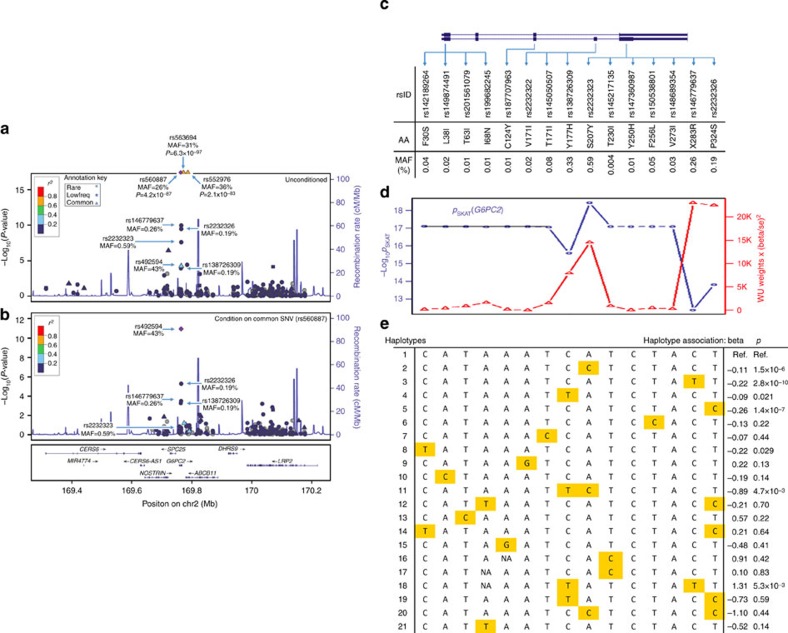
G6PC2.(a) Regional association results (−log10p) for fasting glucose of the G6PC2 locus on chromosome 2. Minor allele frequencies (MAF) of common and rare G6PC2 SNVs from single-variant analyses are shown. P values for rs560887, rs563694 and rs552976 were artificially trimmed for the figure. Linkage disequilibrium (r2) indicated by colour scale legend. y-Axis scaled to show associations for variant rs560887 (purple dot, MAF=43%, P=4.2 × 10−87). Triangle symbols indicate variants with MAF>5%, square symbols indicate variants with MAF1–5% and circle symbols indicate variants with MAF <1%. (b) Regional association results (−log10p) for fasting glucose conditioned on rs560887 of G6PC2. After adjustment for rs560887, both rare SNVs rs2232326 (S324P) and rs146779637 (R283X), and common SNV rs492594 remain significantly associated with FG indicating the presence of multiple independent associations with FG at the G6PC2 locus. (c) Inset of G6PC2 gene with depiction of exon locations, amino-acid substitutions and MAFs of the 15 SNVs included in gene-based analysis (MAF<1% and nonsynonymous, splice-site and gain/loss-of-function variation types as annotated by dbNSFPv2.0). (d) The contribution of each variant on significance and effect of the SKAT test when one variant is removed from the test. Gene-based SKAT P values (blue line) and test statistic (red line) of G6PC2 after removing one SNV at a time and re-calculating the association. (e) Haplotypes and haplotype association statistics and P values generated from the 15 rare SNVs from gene-based analysis of G6PC2 from 18 cohorts and listed in panel (c). Global haplotype association, P=1.1 × 10−17. Haplotypes ordered by decreasing frequency with haplotype 1 as the reference. Orange highlighting indicates the minor allele of the SNV on the haplotype.